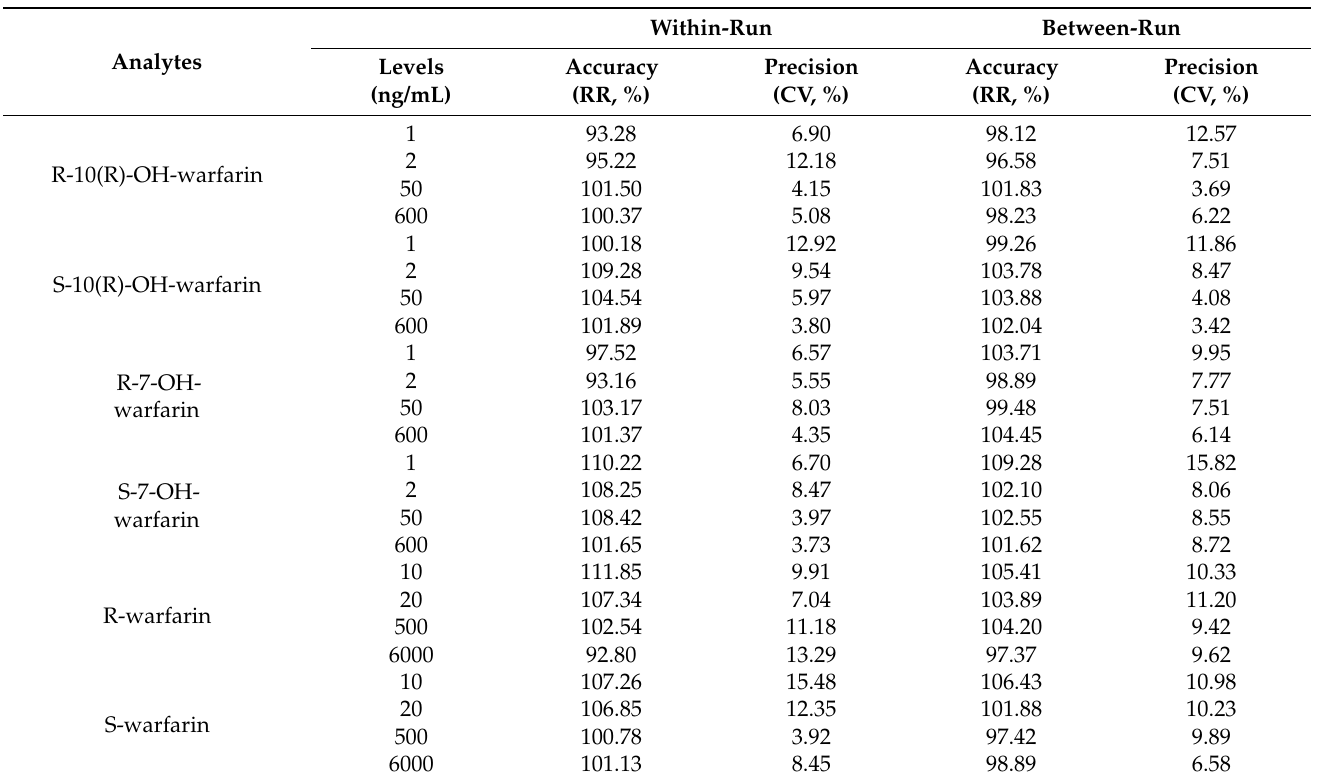
Table 2. The within- and between-run accuracy and precision of warfarin and its hydroxylation metabolites in rat plasma.